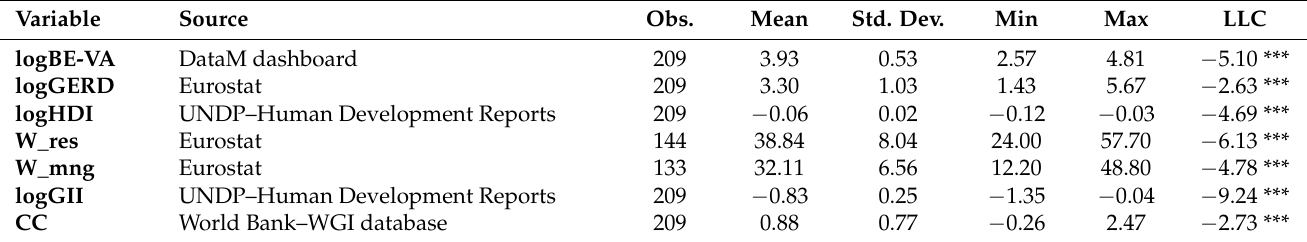
Table 1. Summary statistics, source for the analyzed variables and Levin–Lin–Chu panel unit root test